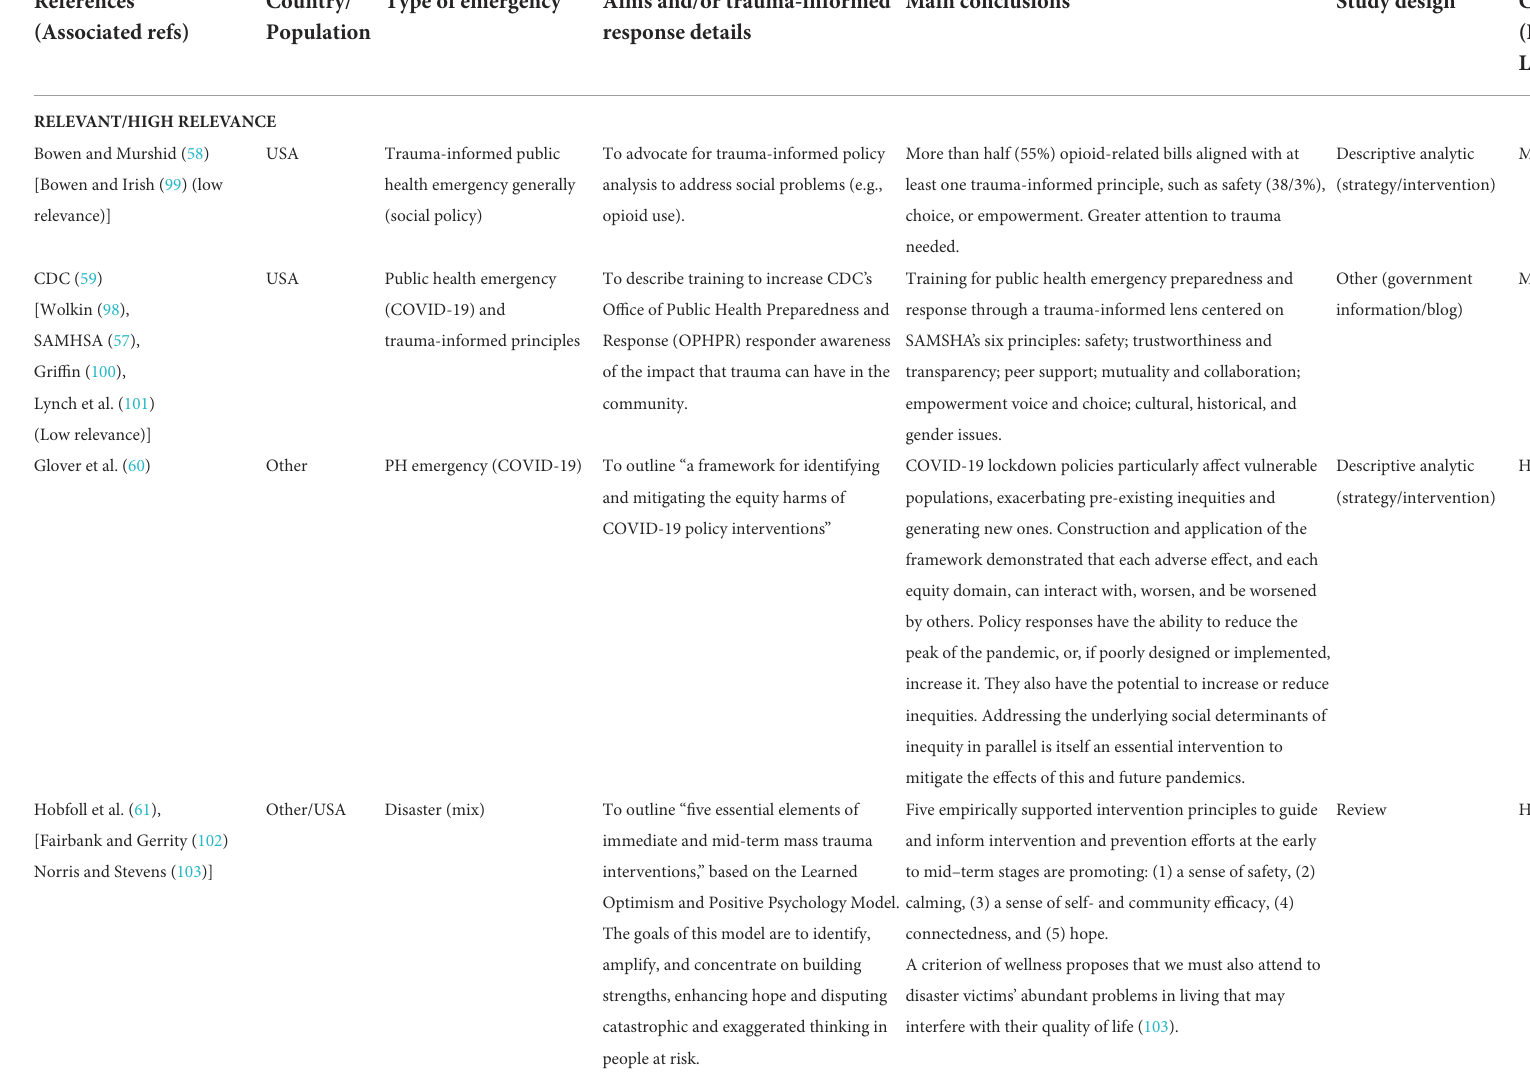
TABLE 1 Characteristics of included